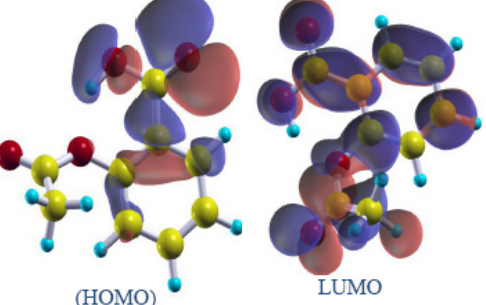
Fig. 9. The isosurfaces of HOMO and LUMO molecular orbitals for isolated non-adsorbed aspirin